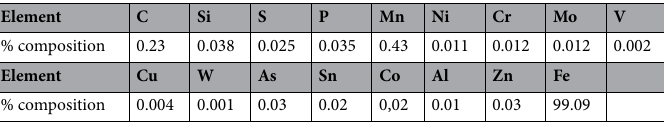
Table 1. Chemical composition of the As-received AISI 1020.